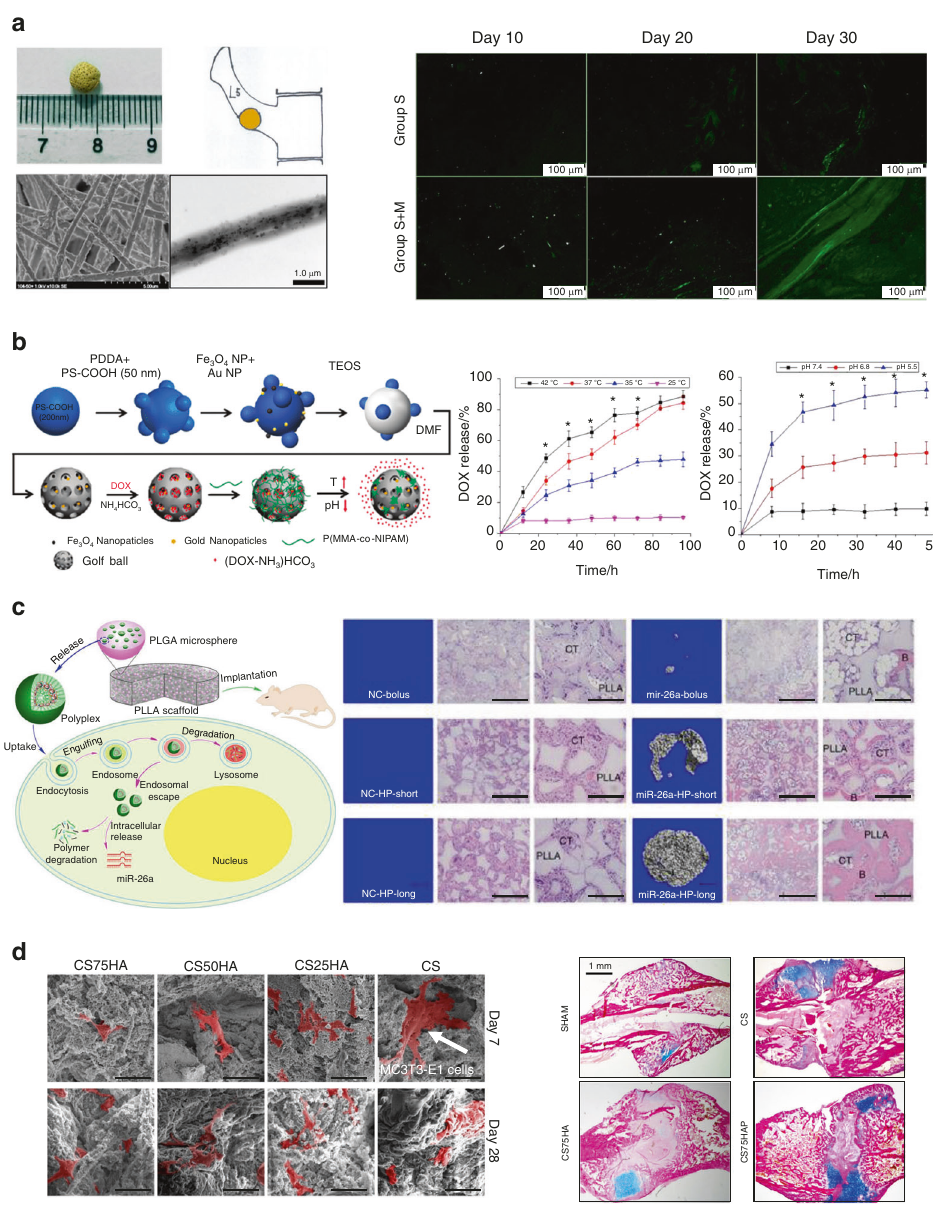
Fig. 5 Examples of smart biomaterials responding to extrinsic stimuli and its response to promote bone regeneration. a Magnetic biomaterials — nano fi brous composite scaffold composed of super-paramagnetic γ -Fe2O3 nanoparticles, hydroxyapatite nanoparticles (nHA), and poly lactide acid (PLA). Left panel: An ~ 5mm scaffolds were implanted in the defect of transverse process of L5 of rabbits. SEM and TEM images show randomly tangled nano fi bers with diameters between 300 and 1 000nm. Right panel: After 30 days of implantation, a higher collagen deposition was found for the scaffold tested under a magnetic fi eld (S + M) compared to the unstimulated group (S). 126 b Magnetic biomaterials — magnetic and gold nanoparticles embedded silica nanoshuttles (MGNSs) with nanopores on their surface. Left panel: The MGNSs are loaded with fl uorescently labeled doxorubicin (DOX) and encapsulated in a thermo- and pH-sensitive polymer to enable the controlled release of the drug into composite human tissues (i.e. bone). Right panel: Pro fi les of DOX release at different temperatures for 100h and at different pH conditions for 50h. 152 c Enzyme- responsive materials — PLLA nano fi brous scaffold containing a hyperbranched polymer with microRNAs polyplexes encapsulated into PLGA microspheres to regenerate critical-sized bone defects. Left panel: The miRNA is released after enzymatic polymer degradation promoting regulation of gene expression. Right panel: A subcutaneous implantation model was used to evaluate the ef fi ciency of delivery of miR-26a in three groups (bolus, short-term, and long-term delivery). There was no appreciable new bone in the negative groups (NC). New bone volume was found for all miR-26a delivery groups, being highest for the long-term delivery group, followed by the short-term and bolus group. 155 Scale bars, 1mm (in microCT images- left images), 500 μ m [in haematoxylin and eosin (H&E) images- center images], 200 μ m (in higher-magni fi cation H&E images at far right). d Enzyme-responsive materials:- Guanosine 5 ′ -diphosphate-cross-linked chitosan scaffolds (CS) with different amounts of Hydroxyapatite (HAp) (75% — CS75HA, 50% — CS50HA, and 25% — CS25HA) were tested with or without pyrophosphatase activity. Left panel: When cultured with MC3T3-E1 cells, a higher number of cells on day 28 was observed compared to day 7, indicating cell proliferation in the scaffolds. For both times points and in all scaffolds the cells showed a spread morphology and well-organized F-actin fi laments. Magni fi cation: 5 000X. Right panel: The in vivo osteogenic properties of the scaffolds was tested in a murine model of rod- fi xation tibia fracture surgery. After 17-days of implantation, an increased callus formation at the fracture site was found for the scaffold with pyrophosphatase and HAp (CS75HAP) by comparison to the control scaffolds lacking both pyrophosphatase and HAp (CS), or pyrophosphatase alone (CS75HA). 169 Figures adapted from refs. 126,152,155,169 with